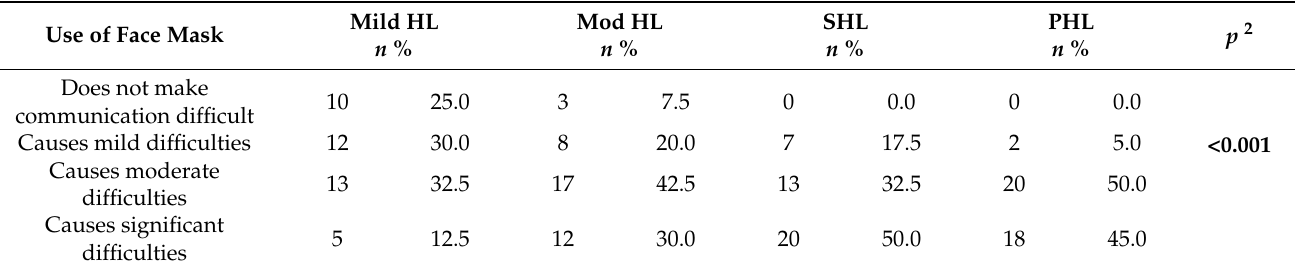
Table 3. Effects of the degree of sensorineural hearing loss on communication due to the use of face mask.